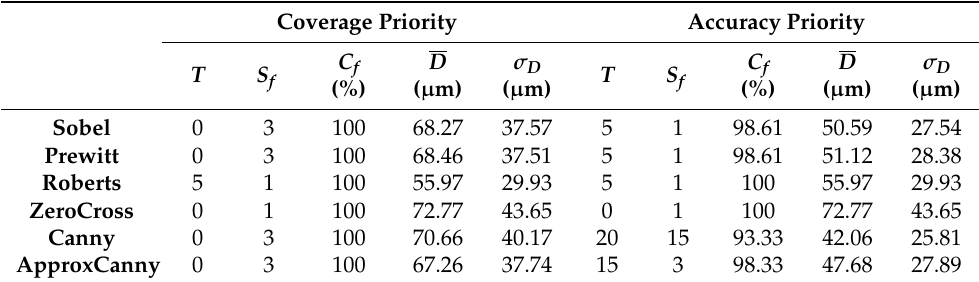
Table 6. Optimal combinations of test parameters for S